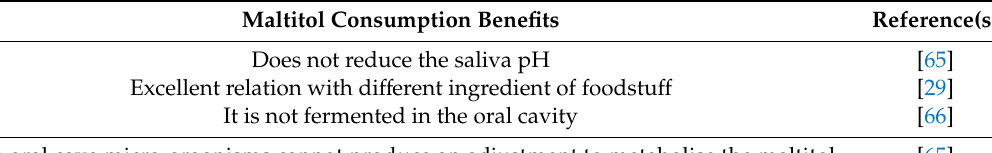
Table 4. Several benefits of the regular consumption maltitol versus other